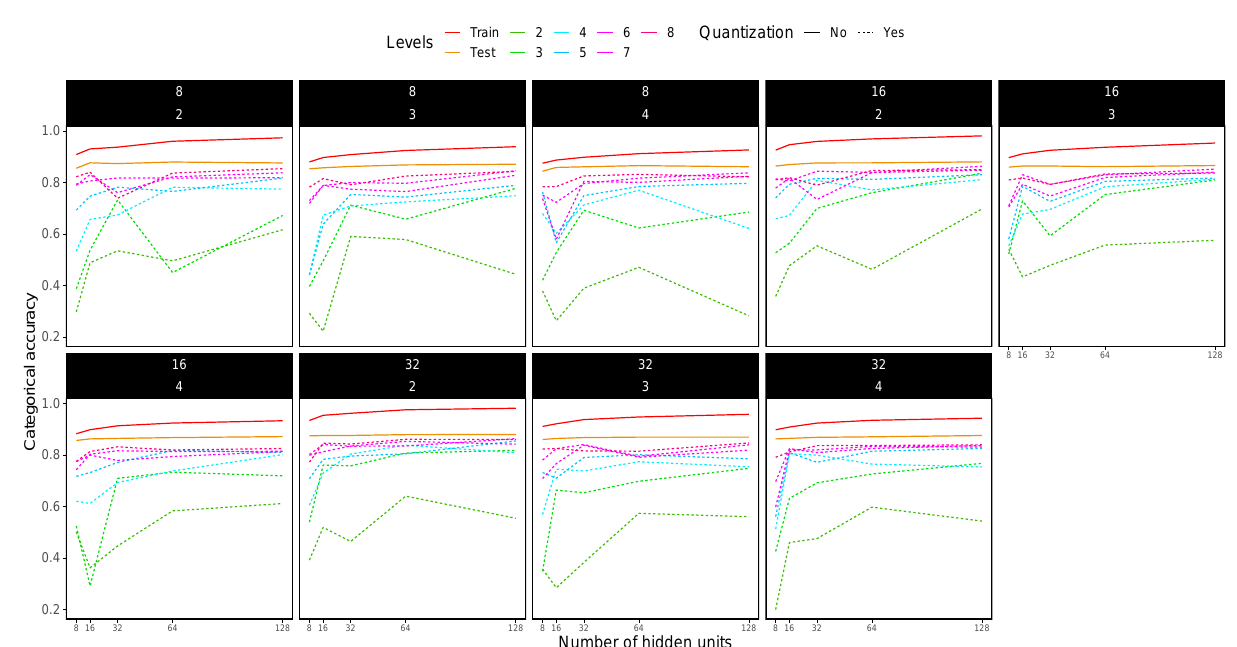
Figure 13. Categorical accuracy for the Fashion MNIST dataset using 2-CNN (i.e., one convolutional layer, one intermediate pooling layer, another convolutional layer and a final pooling layer). Only one hidden layer was used, with hidden units ranging from 8 to 128 ( x axis). Each dashed line in the plots shows the accuracy for different quantization levels, while solid lines indicate no quantization. Each box in the figure shows a particular experiment: convolutional layer with 8, 16 and 32 filters (the top number of the box) and pooling with 2 × 2, 3 × 3 and 4 × 4 matrices (the bottom number of the